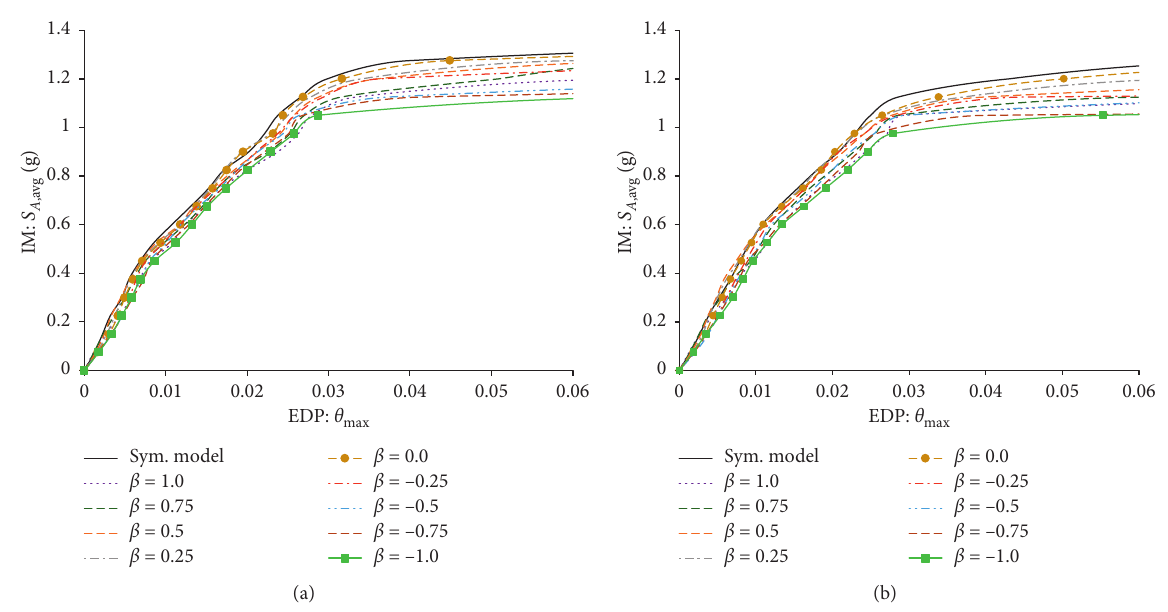
Figure 10: Median IDA curves of the symmetric and asymmetric models: (a) fixed base; (b) flexible